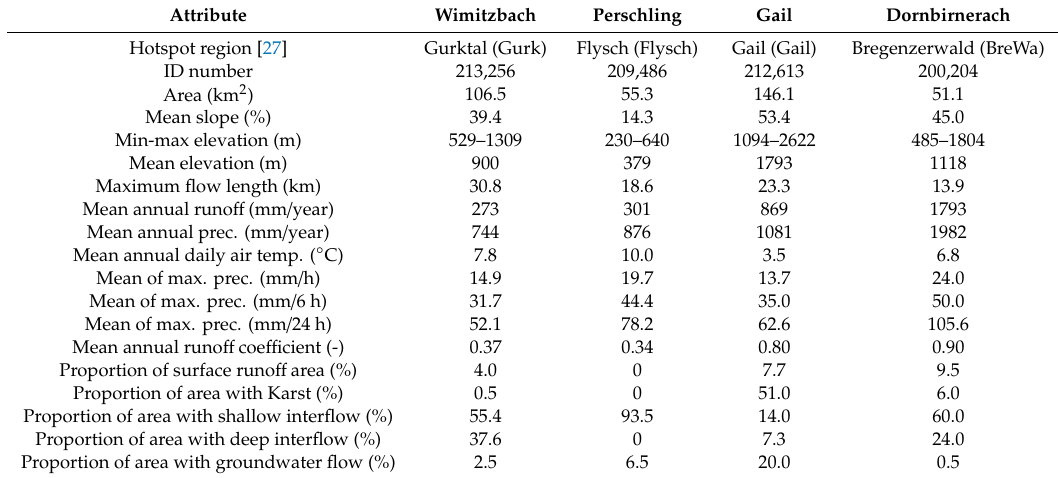
Figure 1. Locations and geological classes of the four catchments presented in this study: ( a ) Wimitzbach, ( b ) Perschling, ( c ) Gail, and ( d ) Dornbirnerach [4]. Streamflow lines are presented as green lines in each catchment. The runoff gauges are shown with circle points, while the rainfall gauges with triangle points. Table 1. Catchment overview. Temporal means of catchment attributes are lumped basin averages from 2002–2013. The hydro-geologic information describes the proportion (area percentage) of the geological classes.